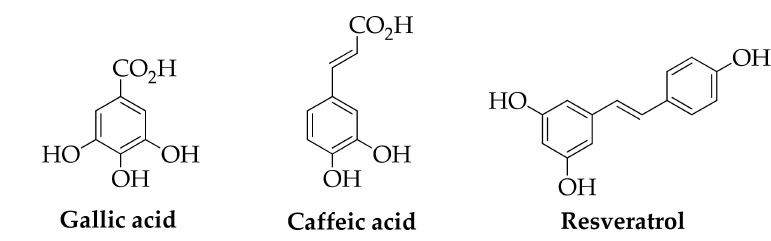
Figure 9. Hydroxybenzoic acids, hydroxycinnamic acids and stilbenes.